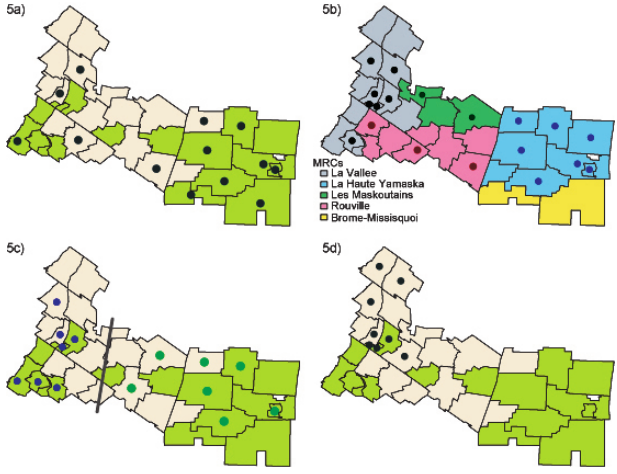
Fig. 5 . Key bridging organizations. a) The most